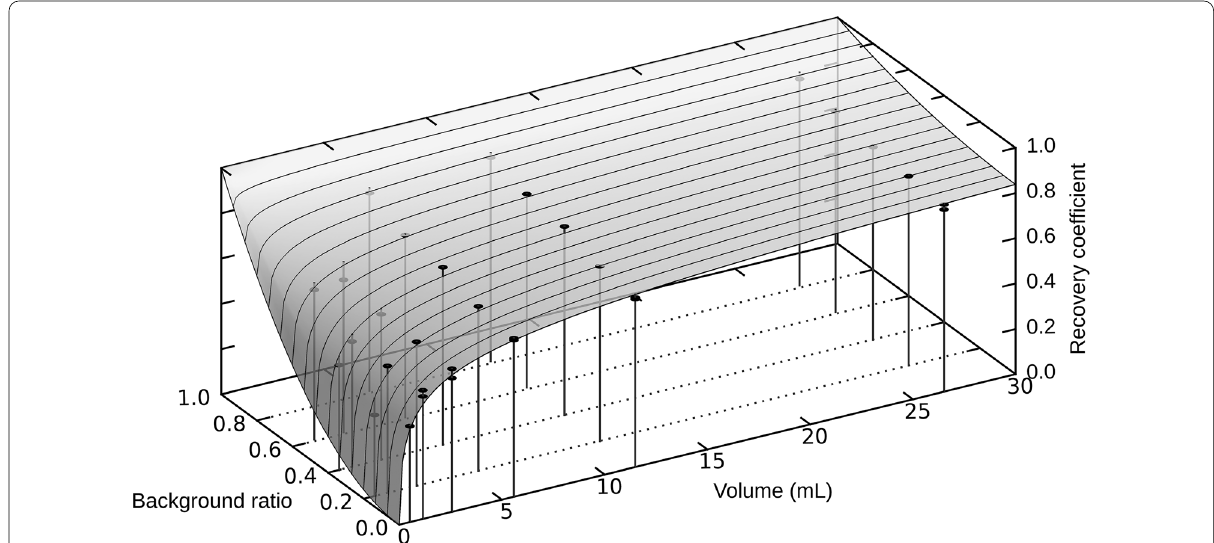
Fig. 6 Measured and fitted recovery coefficient for 68 Ga-PET as a function of sphere volume and background-to-object